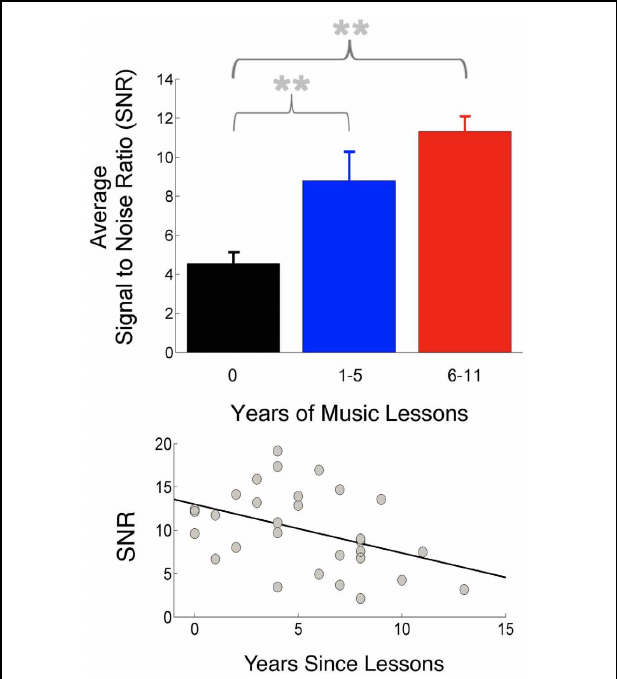
FIGURE 2 | Musical practice during childhood leads to more robust neural responses in adulthood. Top : Participants were divided into three groups based on amount of musical practice. The participant group with no musical training (black) had the smallest amplitudes (highest SNR) in the frequency-following subcortical response compared to groups with more 1–5 years of musical training (blue) and 6–11 years of training (red). Bottom : Response magnitudes correlated with how recently musical training had ceased (adapted from Skoe and Kraus, 2012). ∗∗ p < 0 .